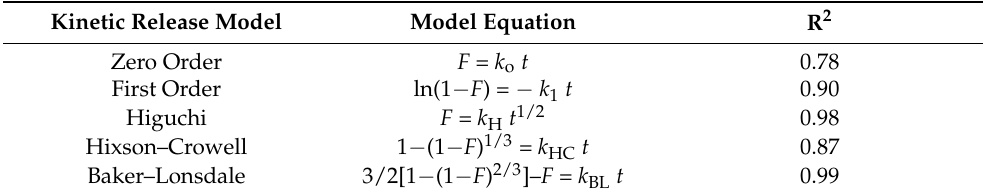
Table 5. Fitting of the experimental release data with different kinetic models. The model equation and the dispersive coefficient are